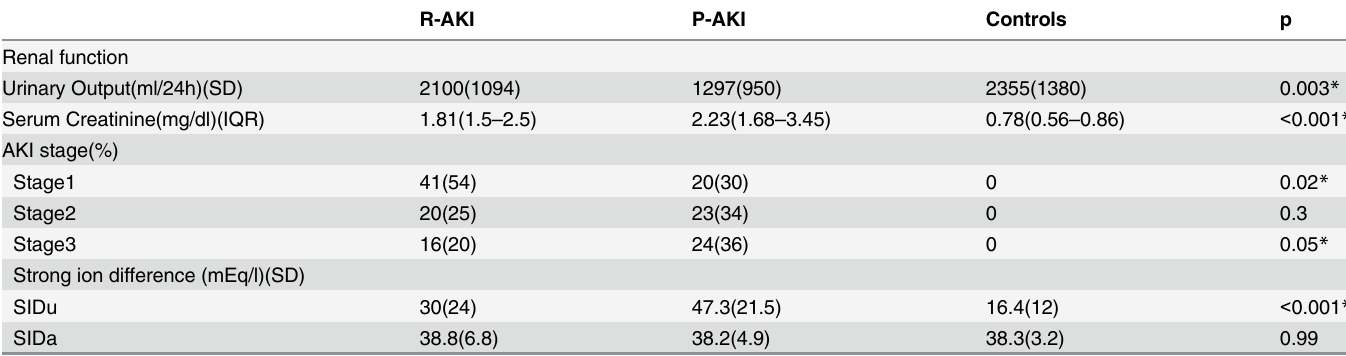
Results reported as means(SD), medians(interquartile range) or n(%).p values are for comparison across the three groups. * is for variables that differ statistically across groups of